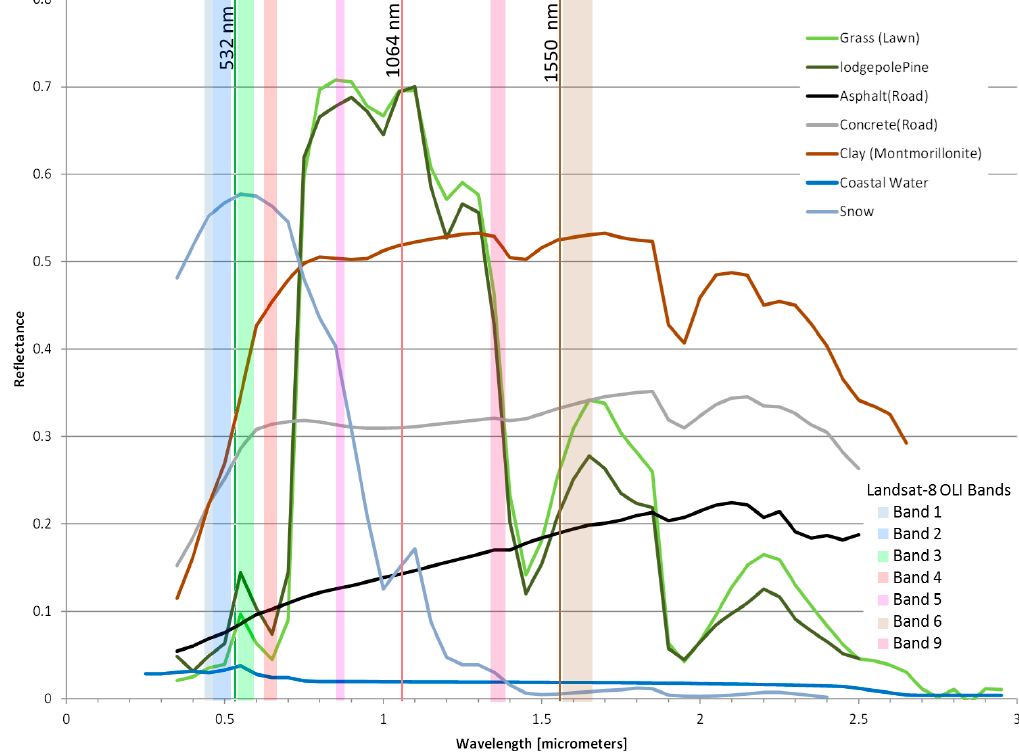
Figure 1. The Titan’s operational wavelengths with reference to reflectance spectra of different land cover features and the Landsat 8 Operational Land Imager (OLI) passive imaging bands.